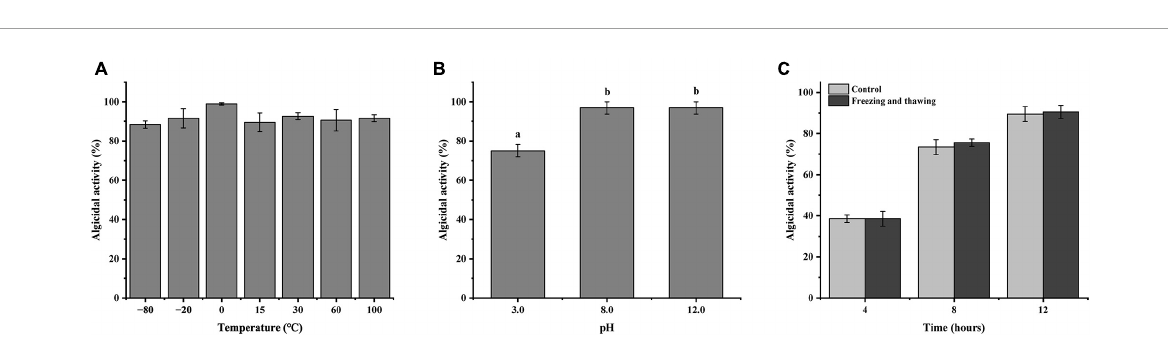
FIGURE6 Algicidal effect of strain LD-B6 cell-free supernatant at different temperatures (A) , pH (B) conditions, and repeated freeze-thaw (C) treatment against Noctiluca scintillans . The error bars represent standard deviations ( n = 3). Different letters a, b represent significant differences between groups ( p <